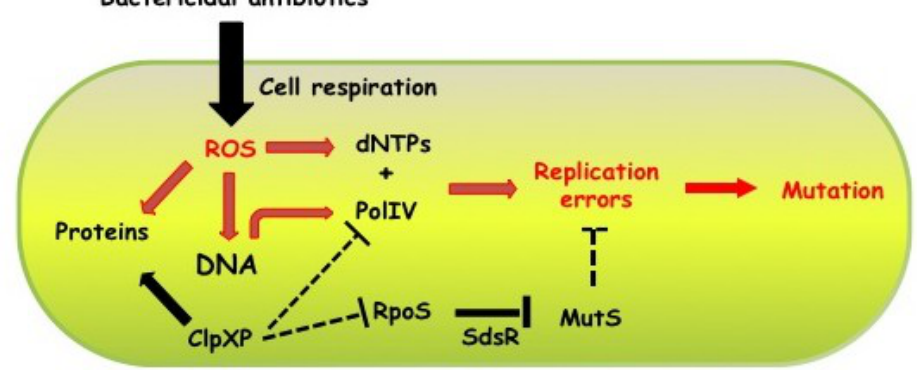
Figure 2. Schematic representation of how Escherichia coli cells modulate mutation rates in response to subinhibitory concentrations of bactericidal antibiotics. Bactericidal antibiotics, like ampicillin, induce ROS production by stimulating cellular respiratory activity. ROS damage all cellular macromolecules, thus promoting, for example, protein oxidation, DNA replication arrest and oxidation of dNTPs pool. In the presence of subinhibitory concentration of ampicillin, the amount of RpoS and PolIV proteins is increased, most likely because the ClpPX protease-chaperon complex, which degrades both RpoS and PolIV, becomes titrated by an increased amount of oxidized proteins. At the same time, the arrest of the DNA replication forks together with higher level of the PolIV error-prone DNA polymerase favors the incorporation of oxidized dNTPs into the DNA, which eventually results in generation of mutations. However, antibiotic-increased mutagenesis is possible only because the mismatch repair system is not able to repair all the PolIV-generated mutations in ampicillin treated cells. The reduction of mismatch repair activity in antibiotic-treated cells is mediated by SdsR, an RpoS-controlled small RNA, which interacts with the mutS mRNA